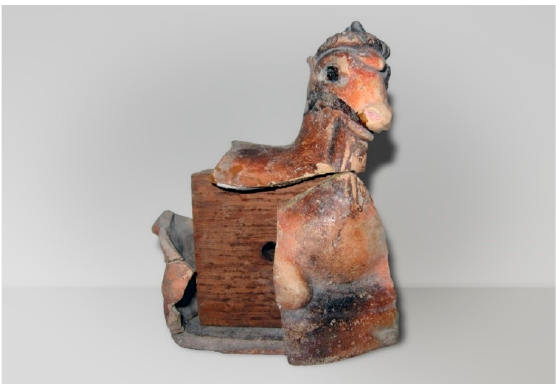
Figure 15. Container in the shape of goat (MGW inv. no. 2450); ceramic vessel; from Birgi, Trapani; ca. 3rd–2nd century BCE .